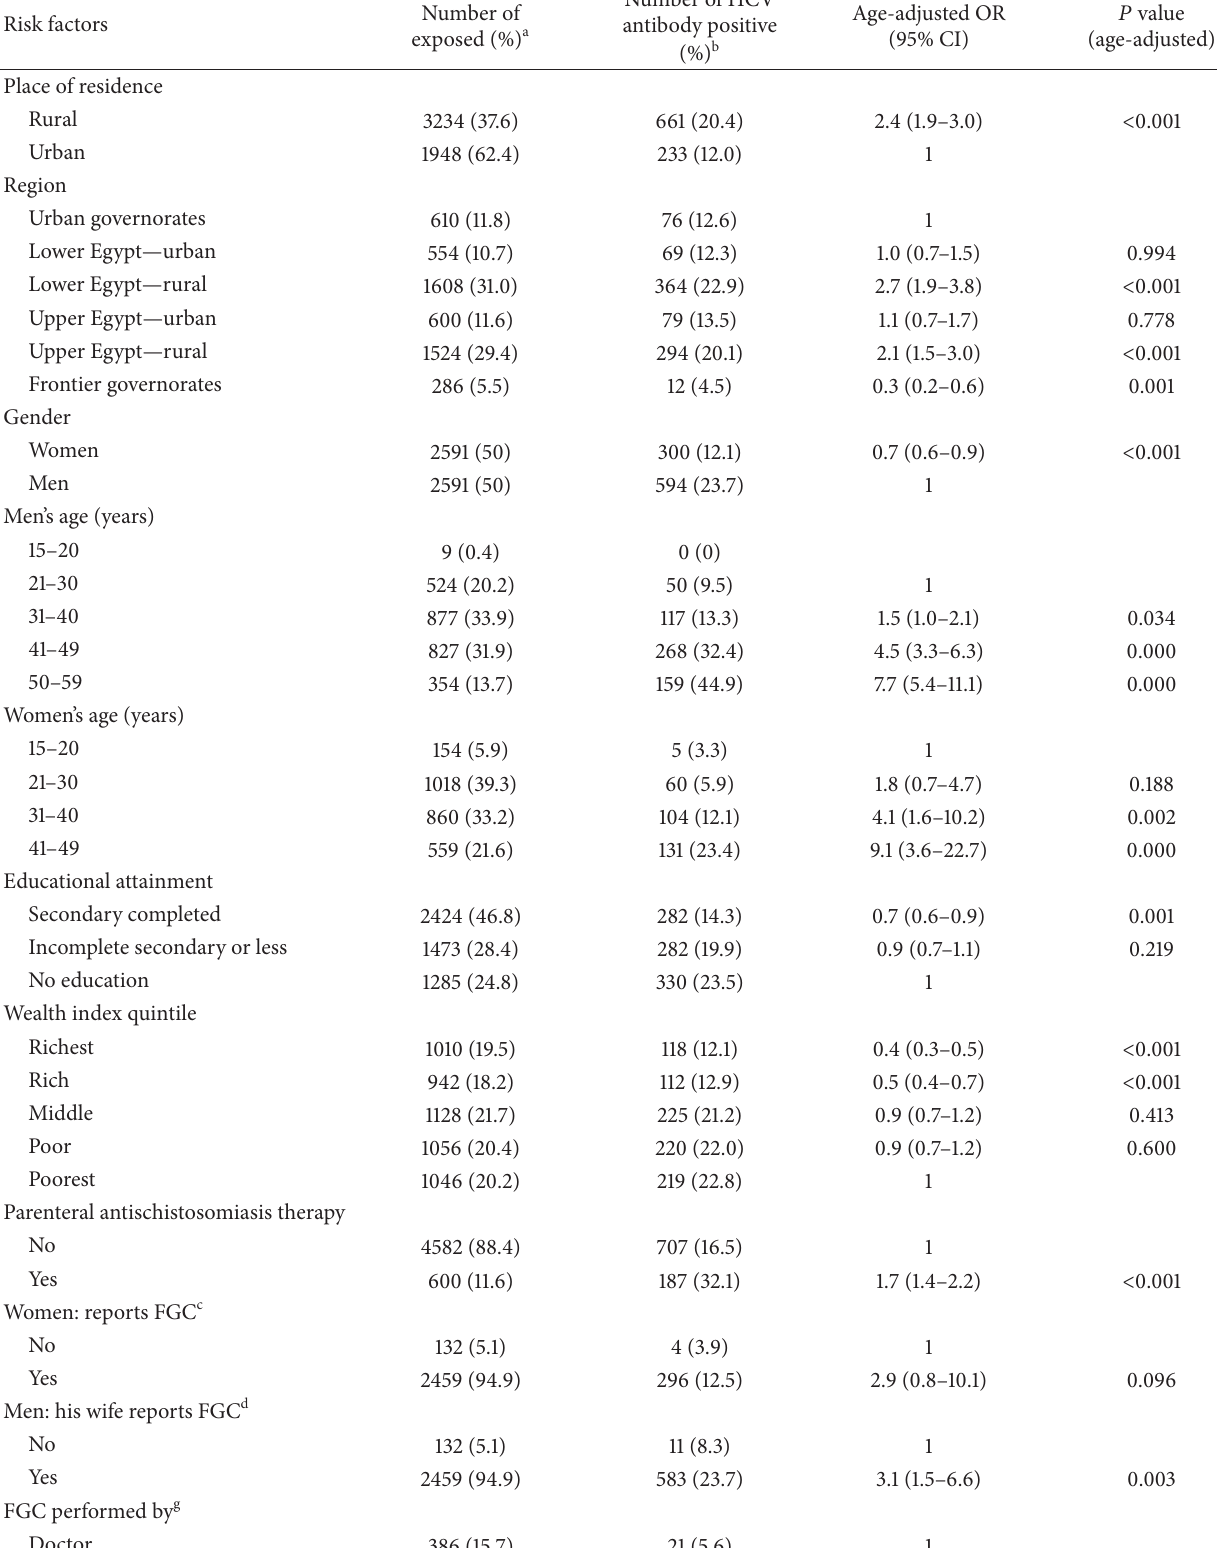
Table 1: HCV seroprevalence and age-adjusted odds ratios for selected characteristics (Egyptian DHS